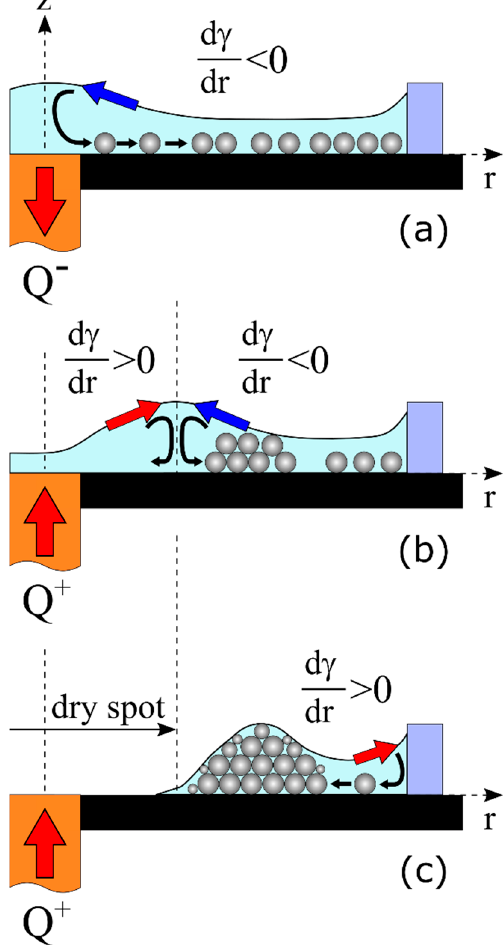
Figure 3. Schematic representation of the ring-shaped deposit formation. ( a ) Cooling mode (the heat is pumped out through the copper rod)—the negative surface tension gradient transfers the liquid to the center, the particles move from the center to the wall. ( b ) Heating mode—competition between negative and positive surface tension gradients, which creates counter rotating thermocapillary vortices. ( c ) Appearance of the dry spot at the central area of the cell due to thermocapillary spreading and evaporation of liquid, and formation of the outer boundary of the ring deposit due to the positive surface tension gradient.